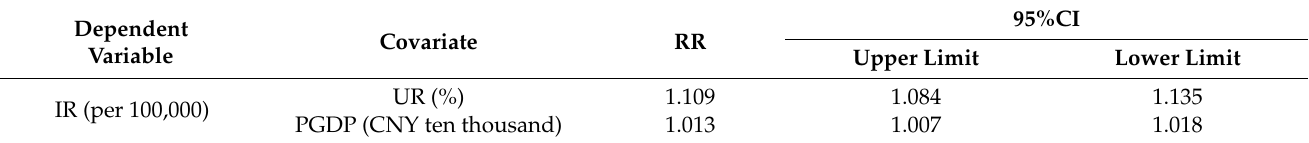
Table 5. Generalized linear model results.